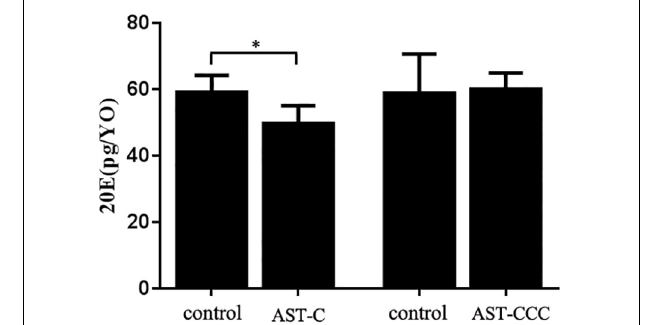
FIGURE 5 | In vitro effects of Scypa AST-C and Scypa AST-CCC peptides on the secretion of 20E by Y-organ of S. paramamosain. The secretion of 20E by Y-organ was significantly inhibited by Scypa AST-C but not effected by Scypa AST-CCC. Data were shown as means ± SEM ( n = 5). Asterisk “ ∗ ” on the error bars indicates the significantly difference from the control ( P < 0.05).